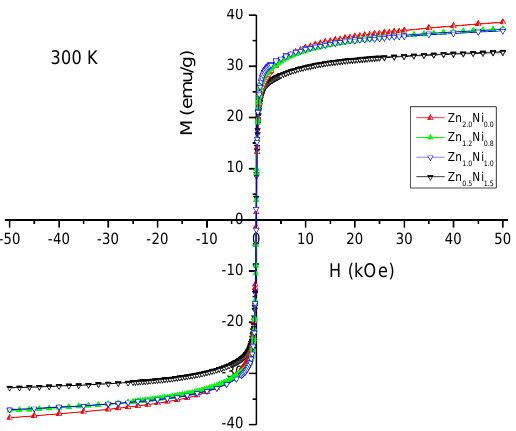
Figure 3. Hysteresis curves of Ba 0.5 Sr 1.5 Zn 2-x Ni x Fe 12 O 22 ( x = 0, 0.8, 1.2, 1.5) at room temperature.